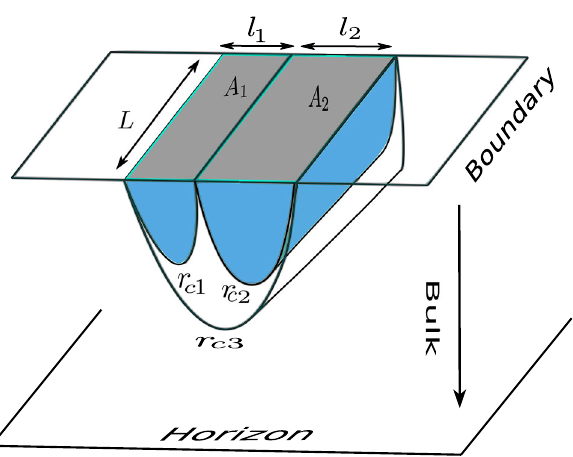
Fig. 1 Schematic of the bulk static minimal surfaces that are anchored on the subsystems A 1 , A 2 and A 1 ∪ A 2 on the boundary CFT 3 dual to the RN- AdS 4 black